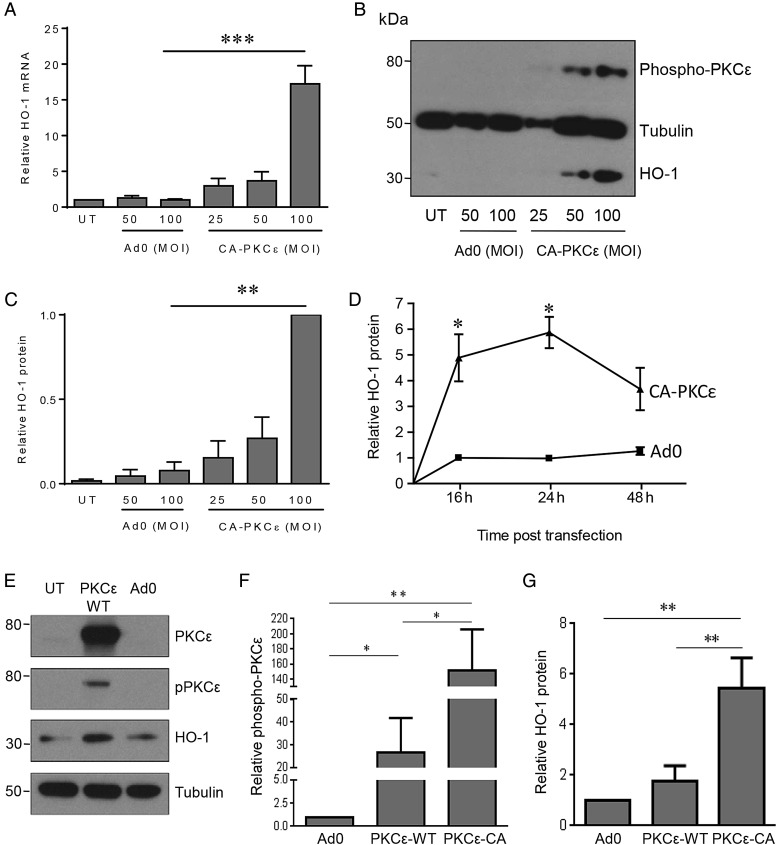
PKCε activation induces HO-1. HUVECs were left untreated (UT) or transfected with Ad0 or CA-PKCε-Adv for up to 24 h (MOI 0–100 ifu/cell), prior to lysis and quantification of (A) HO-1 mRNA by qRT-PCR at 16 h, or (B) HO-1 protein and phosphorylated PKCε(Ser729) by immunoblotting after 24 h, with (C) a histogram showing pooled quantification data from five HO-1 immunoblot experiments. (D) HUVECs were left UT or transfected with Ad0 or CA-PKCε (MOI 100) for up to 48 h and HO-1 analysed by immunoblotting (n = 3). (E, F, and G) HUVECs were left UT or transfected with Ad0 or WT-PKCε-Adv for up to 24 h (MOI 25 ifu/cell), prior to lysis and quantification of PKCε, PKCε(Ser729), and HO-1 by immunoblotting (n = 3). Data are presented as mean ± SEM normalized to the UT control except in (C), where densitometry data are presented relative to the maximal expression with CA-PKCε (MOI 100), on account of minimal basal HO-1 protein expression (ANOVA, *P < 0.05, **P < 0.01, ***P < 0.001).